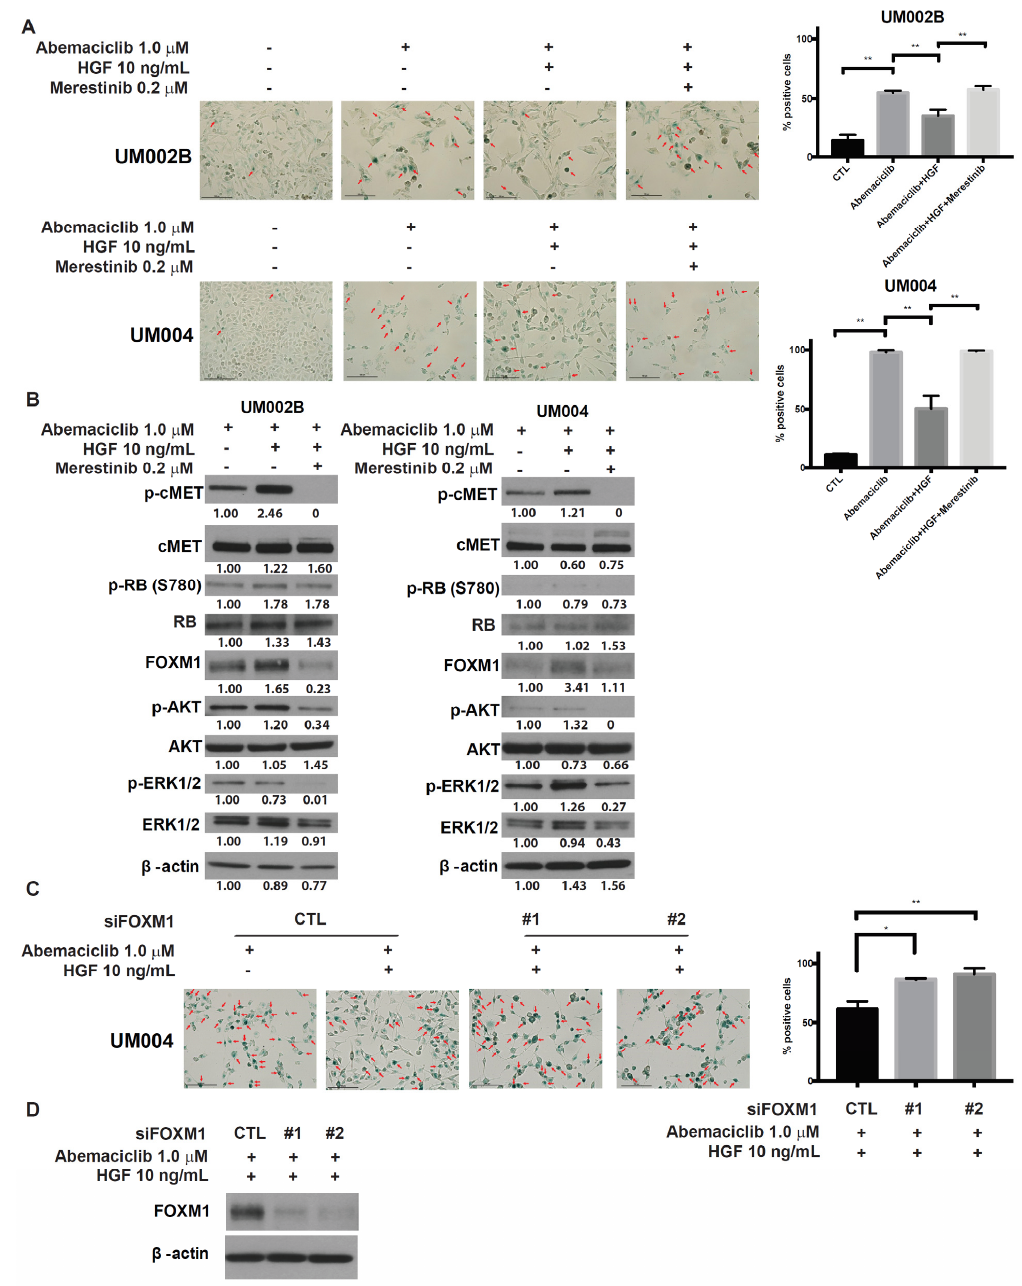
Figure 5. HGF prevents abemaciclib induced-cell senescence and merestinib reverses HGF effects. ( A ) UM002B and UM004 cells were treated with DMSO or 1 μ M of abemaciclib, in combination with 10 ng/mL of HGF and/or 0.2 μ M of merestinib for six days. Cells were fixed and stained overnight for senescence-associated β -galactosidase activity. Positive cells were shown with arrows. Data are presented as mean ± SD. *, p < 0.05; **, p < 0.01, based on Tukey analysis. ( B ) UM002B and UM004 cells were treated with 1 μ M of abemaciclib, in combination with 10 ng/mL of HGF and/or 0.2 μ M of merestinib for 72 h. Activation of cMET, RB, FOXM1, AKT, ERK1/2, and p70S6K was analyzed by Western immunoblotting. ( C ) UM004 cells were transfected with control or FOXM1 targeting siRNA (#1 and #2) and cultured with 1 µ M of abemaciclib in the presence or absence of 10 ng/mL of HGF for six days. Following six-day treatment, cells were fixed and stained overnight for senescence-associated b-galactosidase activity. Positive cells were shown with arrows. Knockdown of FOXM1 reversed the evasion of cellular senescence mediated by HGF. ( D ) UM004 cells were transfected with control or FOXM1 targeting siRNA (#1 and #2) in the presence of 1 µ M of abemaciclib and 10 ng/mL of HGF for 72 h. FOXM1 and β -actin were analyzed by Western